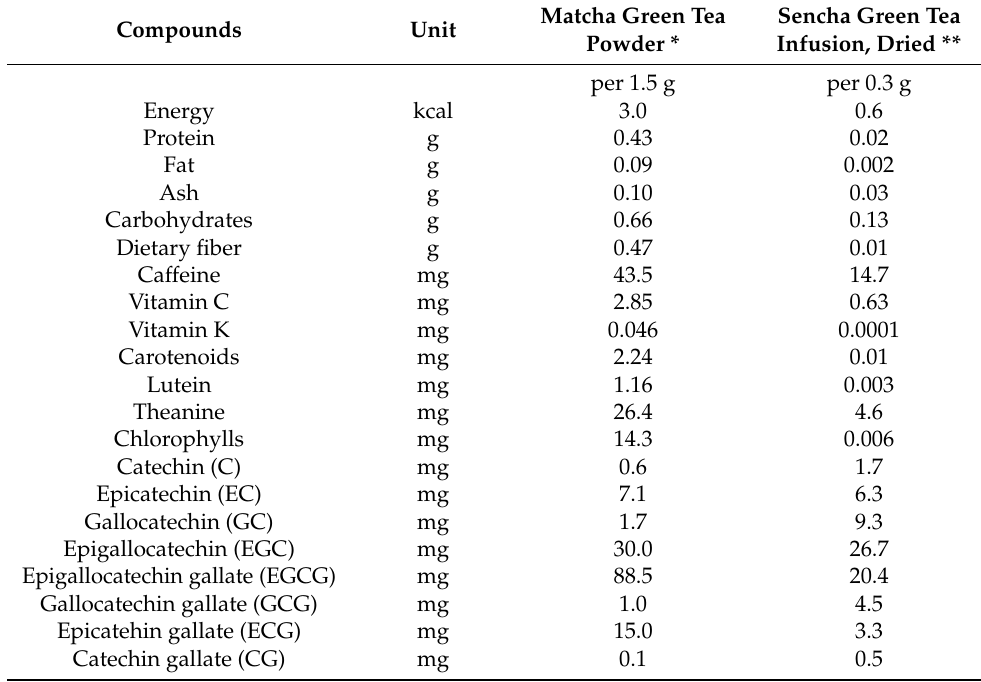
Table 1. Composition of matcha green tea powder and dried Sencha green tea infusion per cup consumption. Compounds Unit